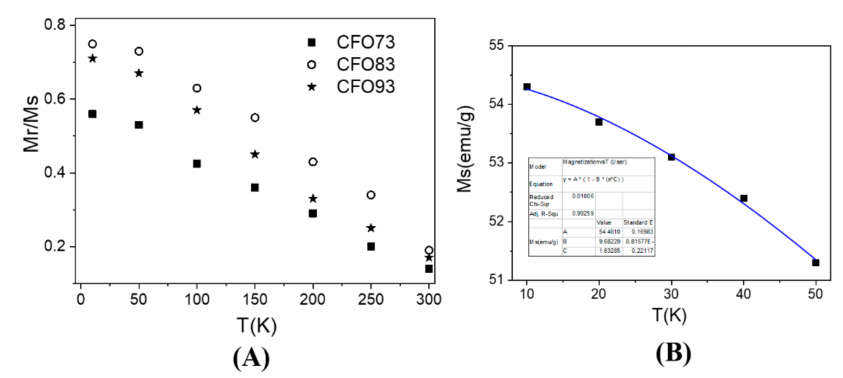
Figure 7. Mr / Ms for all samples ( A ) and thermal dependence of magnetization at saturation (Ms) for sample CFO73 ( B